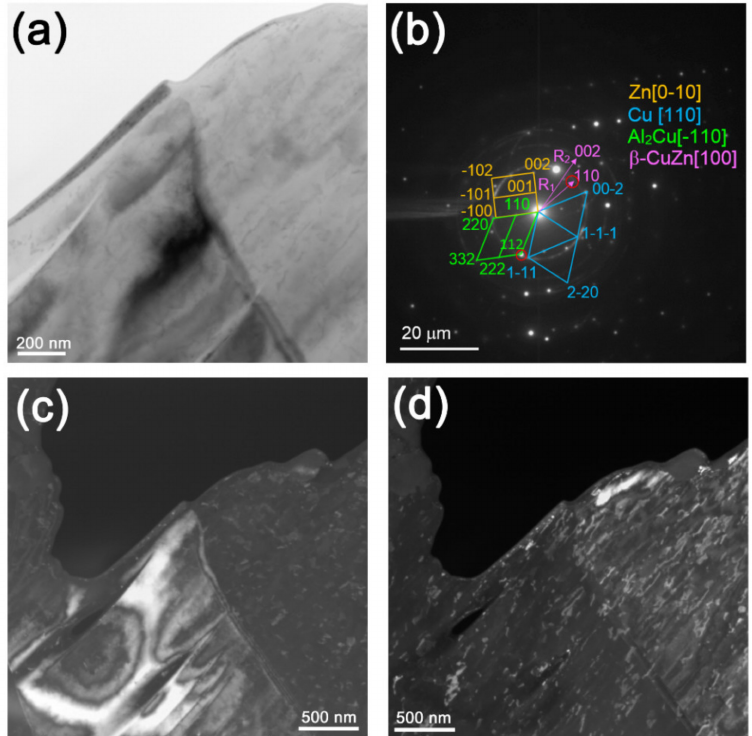
Figure 7. Bright-field image ( a ), SAED pattern ( b ), dark-field image ( c ) obtained using reflections (112) θ and (–110) CuZn , and dark-field image ( d ) obtained using reflections (–110) CuZn .